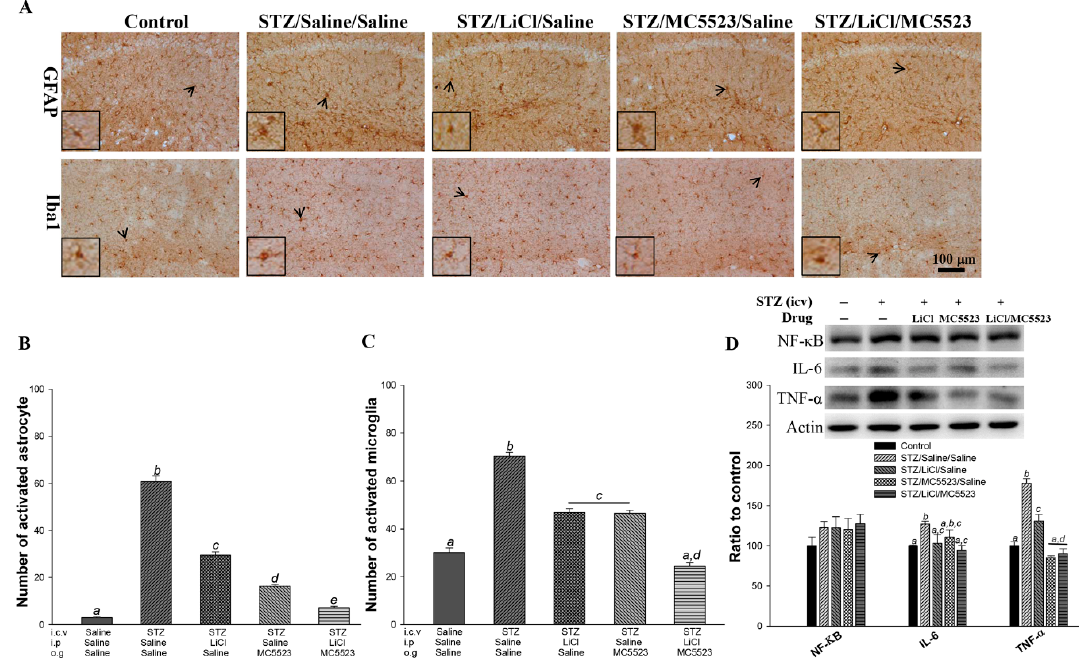
Figure 6. MC5523 greatly decreased the level of gliosis in the LiCl-treated icv-STZ B6 mice. (A) Representative images of astrocytes (with GFAP staining) and microglia (with Iba1 staining) in the hippocampus. Scale bar = 100 µm, and the arrowheads indicate positive staining signals. (B – C) The number of activated astrocytes and microglia in the hippocampus. (D) Representative western blots and densitometry results of NF- κ B, IL-6, and TNF- α with β -actin serving as an internal control. The quantitative data are shown as the mean ± SEM ( n = 3–5 per group). * p < 0.05 and *** p < 0.001 compared with the saline/saline/saline control group. Means that do not share a letter are significantly different ( p < 0.05).